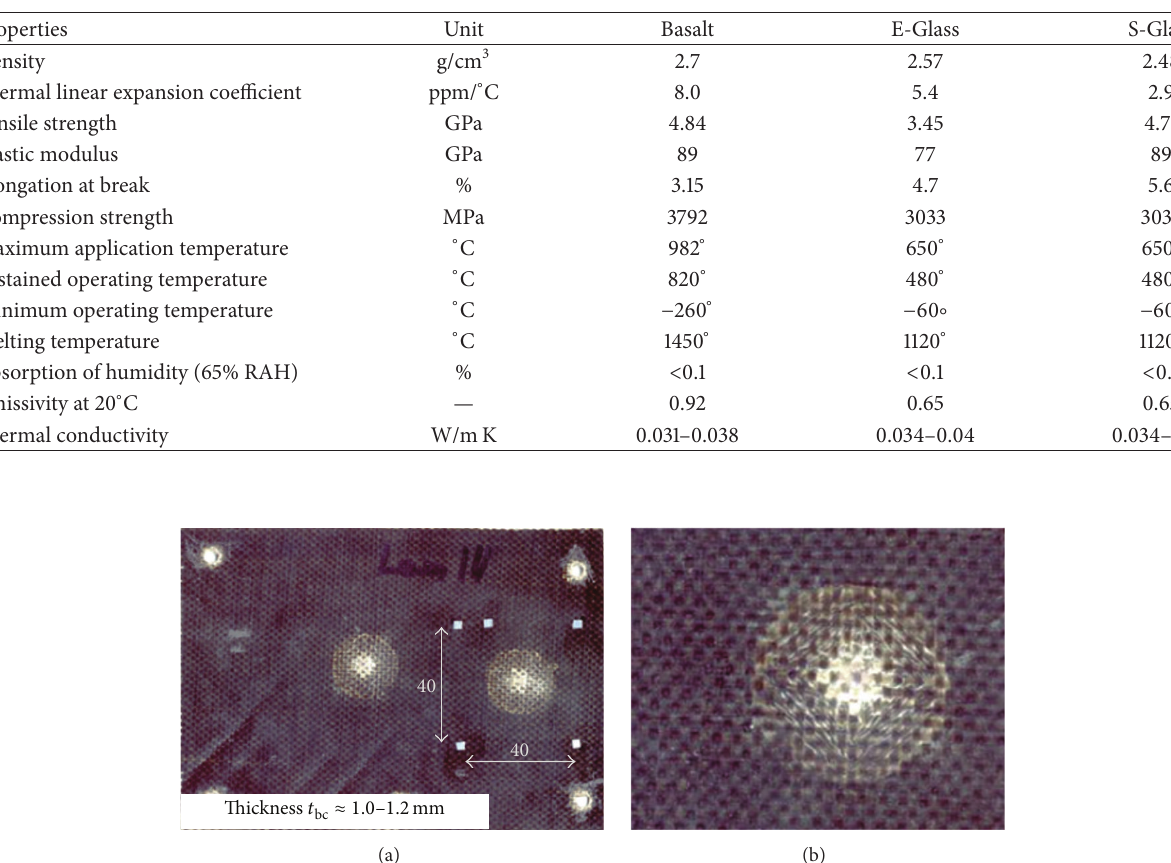
Table 1: Selected properties of basalt and glass fibers [7, 8].